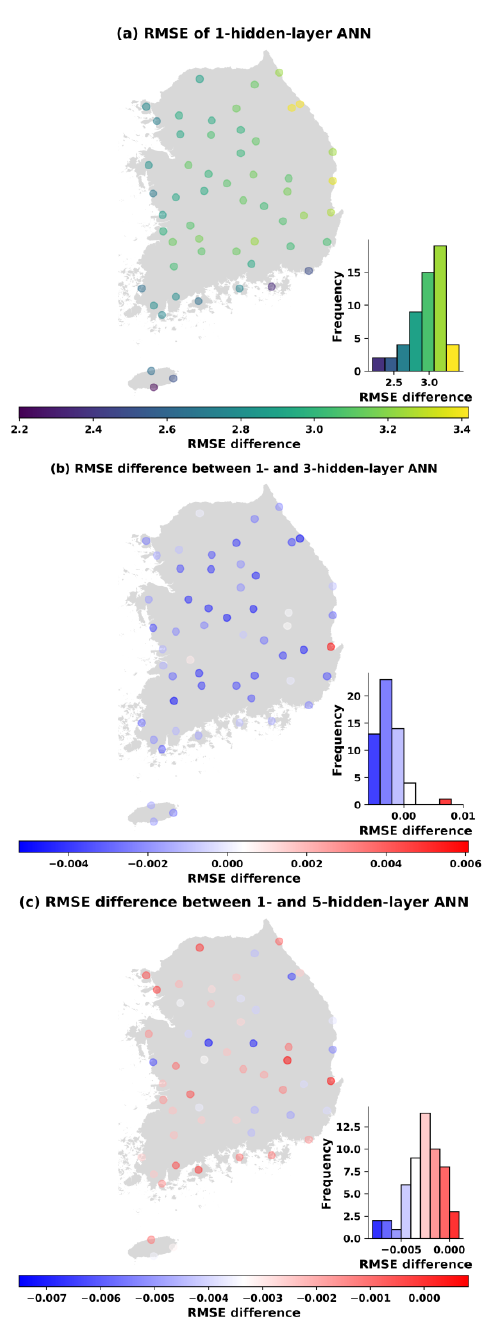
Figure 10. Panel ( a ) shows the RMSE of the test data of the 1-hidden layer model with 1001 parameters; panel ( b ) shows the di ff erence of the RMSE between 1-hidden layer and the 3-hidden layer model (RMSE di ff erence < 0 indicates that the 1-hidden layer model performs better than the 3-hidden layer model and vice versa); and panel ( c ) shows the RMSE di ff erence between the 1-hidden layer and the 5-hidden layer model (RMSE di ff erence < 0 indicates the that the 1-hidden layer model performs better, RMSE di ff erence > 0 shows the opposite).